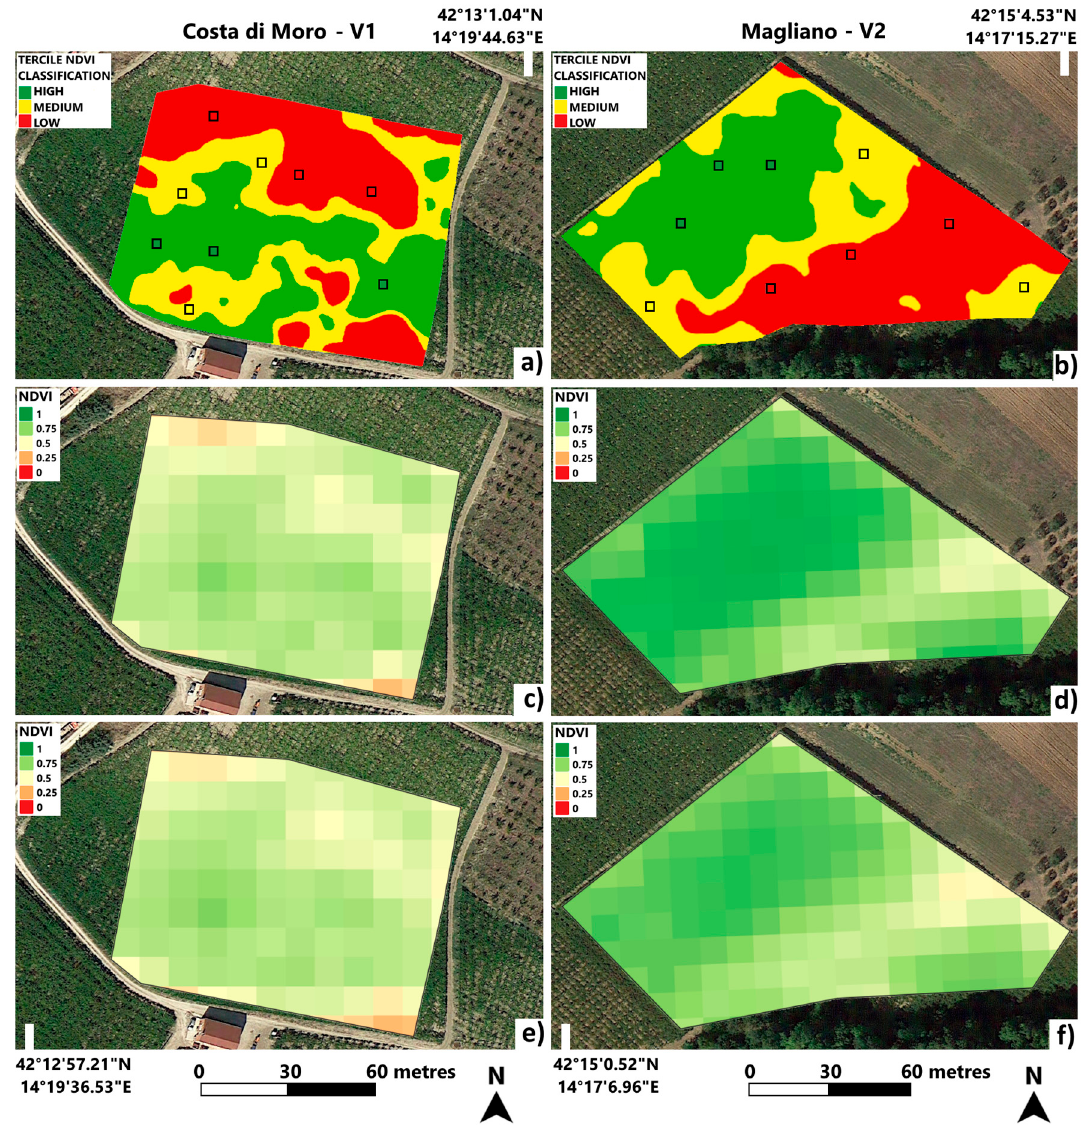
Figure 2. Study vineyards Costa di Moro (V1, left) and Magliano (V2, right) vigor maps, elaborated from UAV ( a , b ) and from Sentinel-2 ( c , d images of 30 August 2015; e , f images of 19 September 2015).